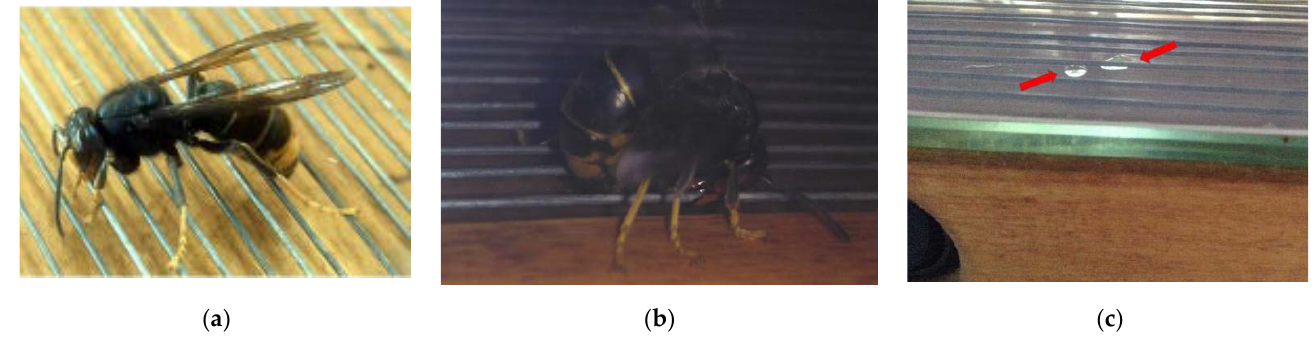
( c ) Figure 2. A captured female Vespa velutina specimen by aril netting: ( a ) Walking up into the net bag; ( b ) Trapped in a fold of the tip net bag; ( c ) Inside the designed chamber for venom extraction. 2.2. Electric Stimulation The Vespa velutina venom extraction chamber is lightweight (1.3 kg) and mobile, so it can be used out in the field. The electrical venom collection device is an all-in-one solid, smart compact, working with automatic tuning where a microprocessor monitors and ad- justs pulses, based on humidity, number of insects, how long the device has been running, the battery level, and the venom collector’s overall condition. The access to the on/off but- ton allows users to operate the device safely. Every 50 s, the device pauses for 10 s. After 40 min of work time, the device turns off automatically. That was the maximum time for Vespa velutina venom collection in one session, for a total of 10 individuals.